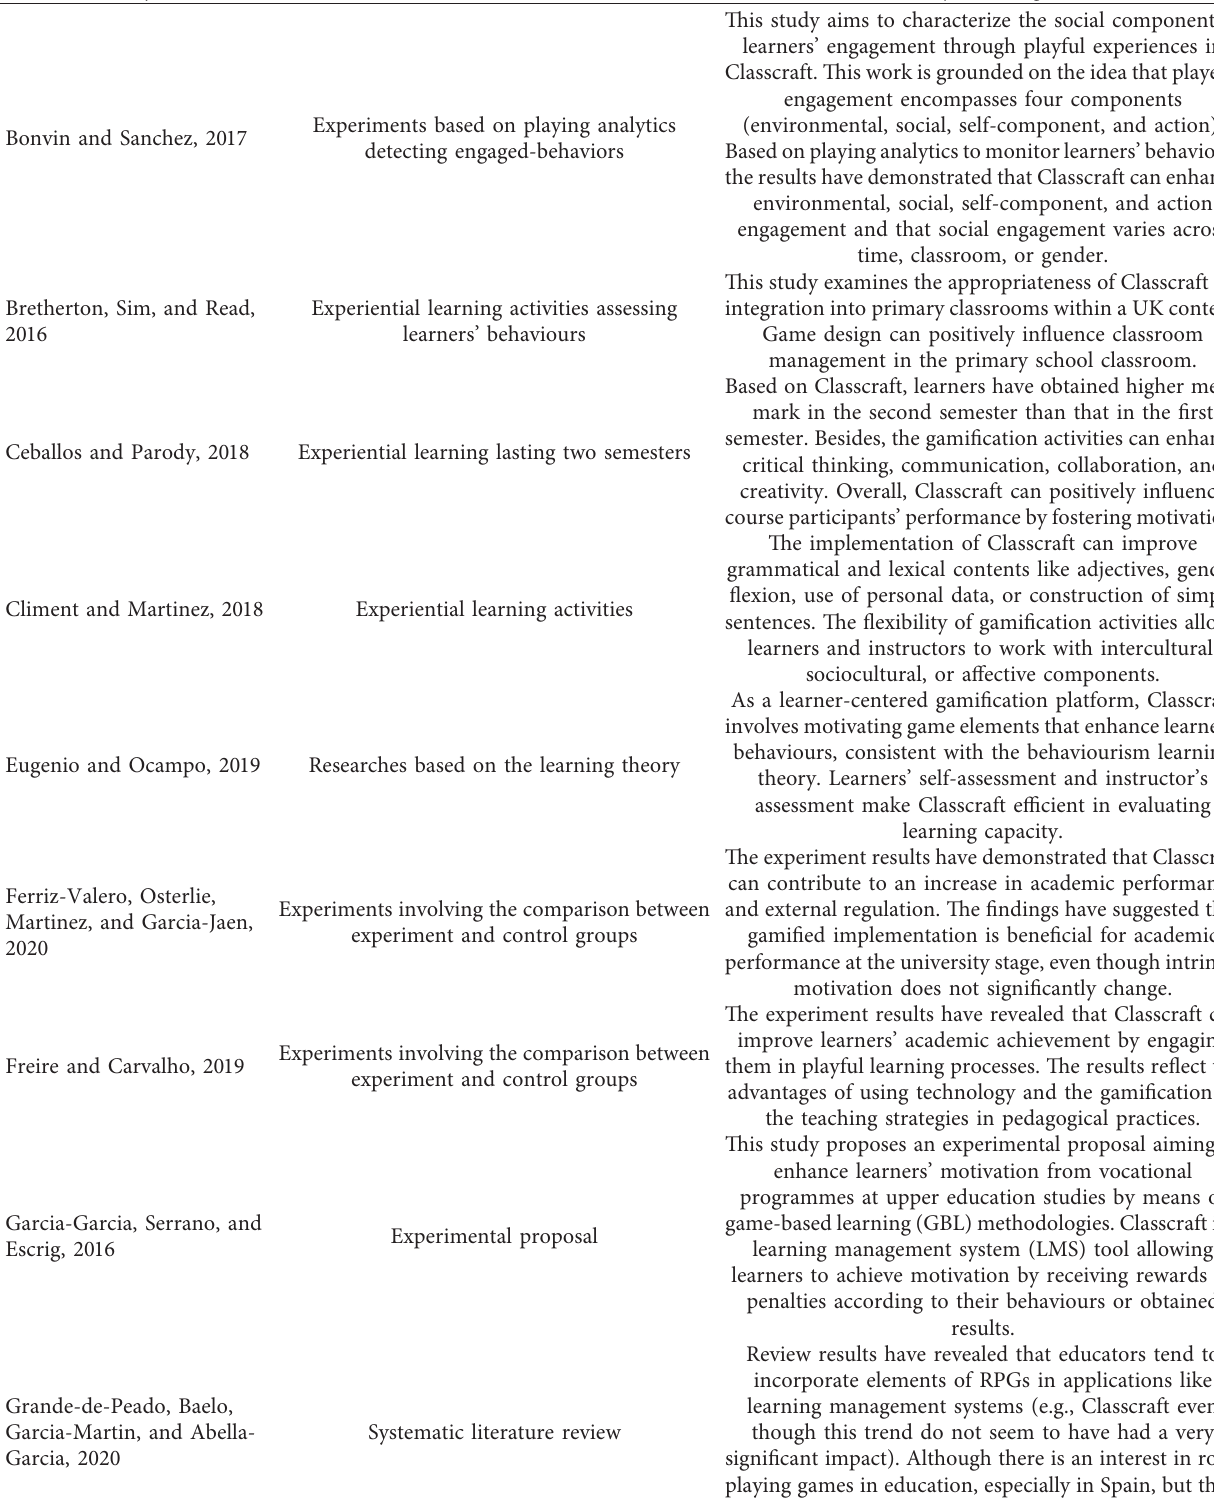
Table 1: The studies on Classcraft and extracted for the content